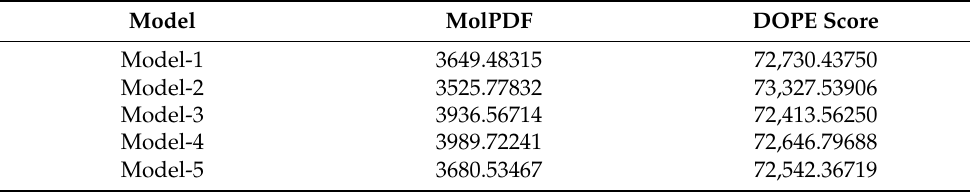
Table 3. DOPE profiling of homology models created by